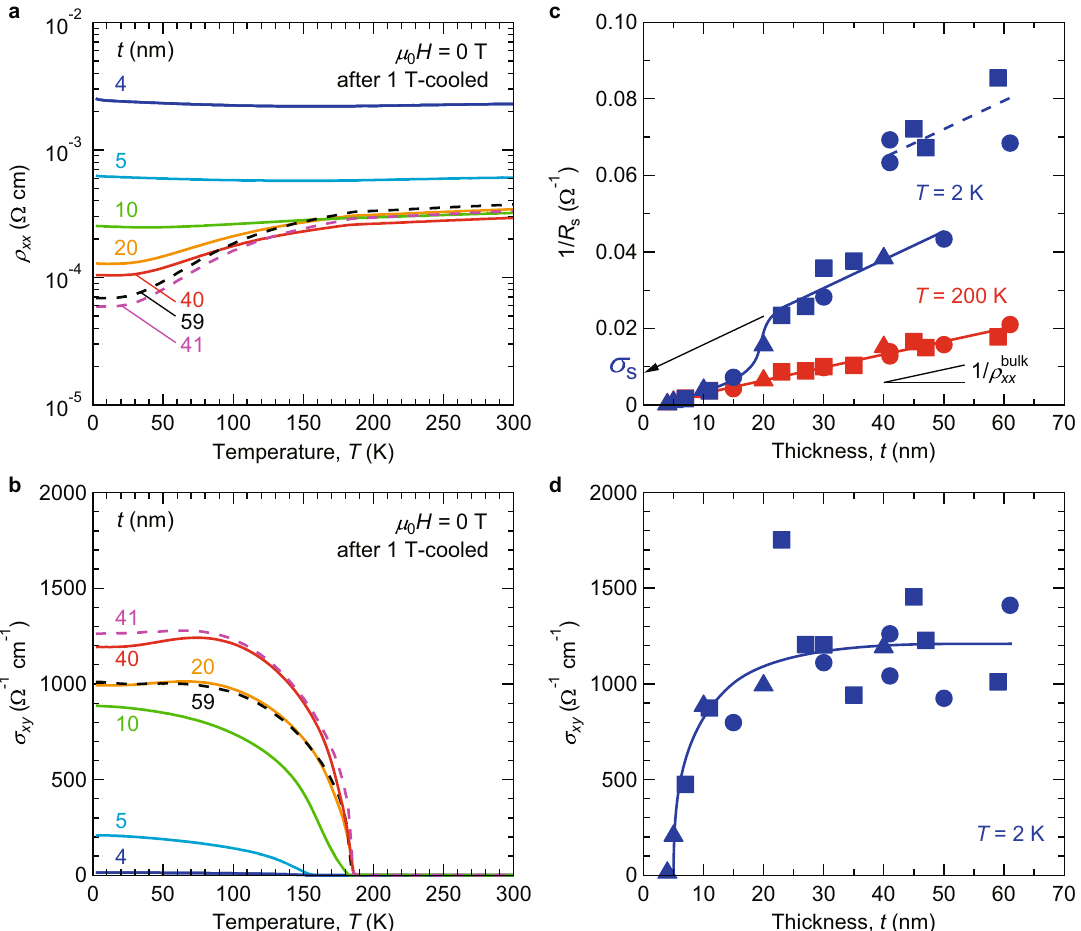
Fig. 3 Critical t for the emergence of Weyl features in electrical transport properties. a , b T dependence of ρ xx and σ xy measured at zero fi eld after fi eld- cooled at μ 0 H = 1 T, respectively. The used sputtering targets were A for t = 41 nm, B for t = 40, 20, 10, 5 and 4 nm, and C for t = 59 nm. c t dependence of − 1 at T = 2 K (blue symbols) and 200 K (red symbols). The red solid line is a linear fi t to the data at T = 200 K. The blue solid and dashed lines for the R s data at T = 2 K represent two sample groups with different σ s values. The blue solid curve is a guide to the eye. d t dependence of σ xy at T = 2 K. The blue solid curve is a guide to the eye. Symbols in c and d correspond to the used sputtering targets: A (circles), B (triangles) and C (squares).